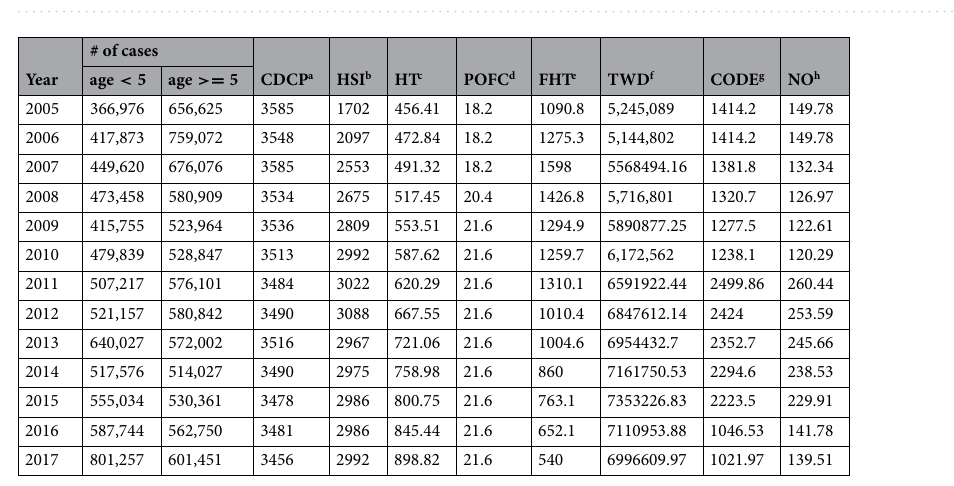
Figure 5. Provincial numbers of infectious diarrhea cases with regard to different age groups in mainland of China, in 2005 and 2017. The age groups are divided into two: under and over 5 years. The map is generated by an open source package called pyechart in Python 63 .